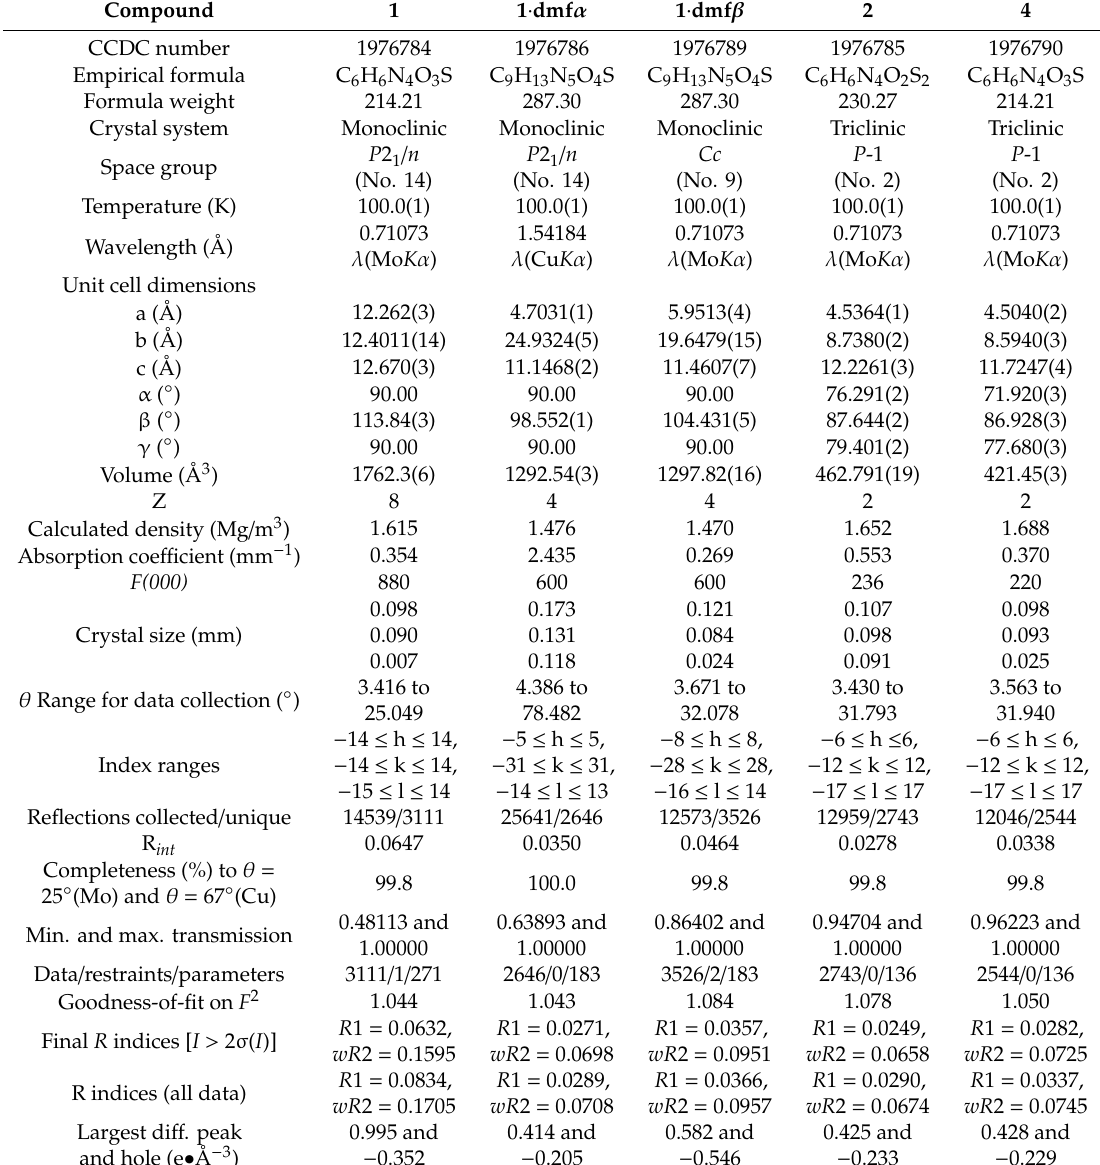
Table 1. Crystal data and structure refinement details for the studied